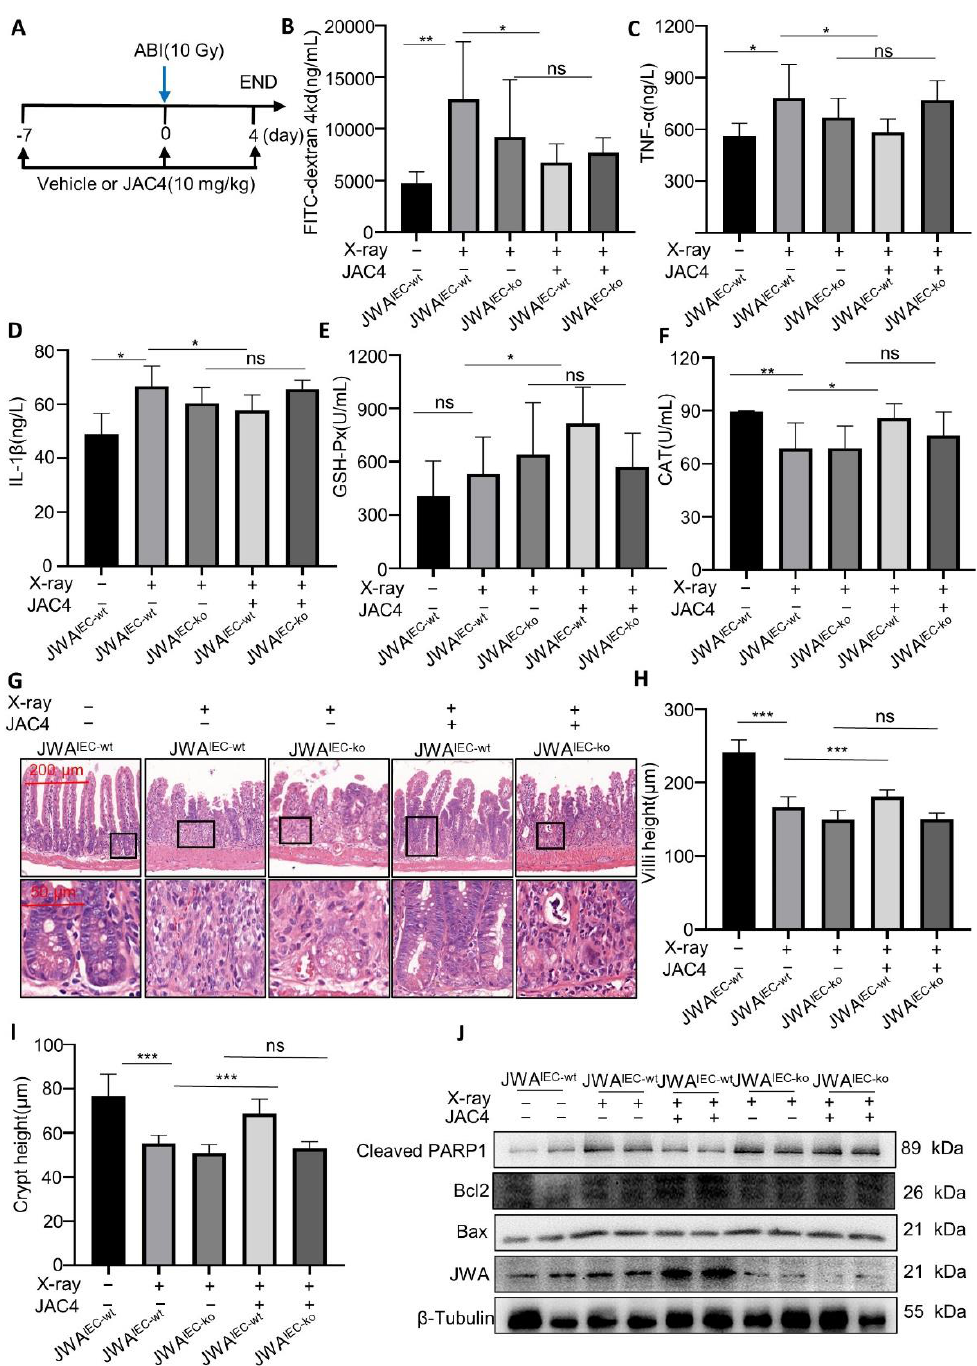
Figure 6. JWA is necessary for JAC4 protecting mice from X-ray exposure-induced intestinal barrier damage. ( A ) Both the JWA IEC-ko and JWA IEC-wt mice were administered JAC4 (10 mg/kg) or vehicle by gavage for 7 days, and the mice were then exposed to X-ray radiation (10 Gy); JAC4 treatment was continued for four days. ( B ) The concentration of FITC-dextran in the plasma. ( C , D ) The concentration of IL-1 β and TNF- α in the plasma. ( E , F ) The activity of catalase (CAT) and glutathione peroxidase (GSH-Px) in the plasma. ( G – I ) H&E staining of small intestine and quantification of the villus height and crypt height. ( J ) Western blot analysis was performed for JWA, cleaved PARP1, Bax, and Bcl-2 after 10 Gy radiation. The results are expressed as mean ± SEM (n = 5 or 6) (* p < 0.05; ** p < 0.01; *** p < 0.001; ns: p > 0.05).